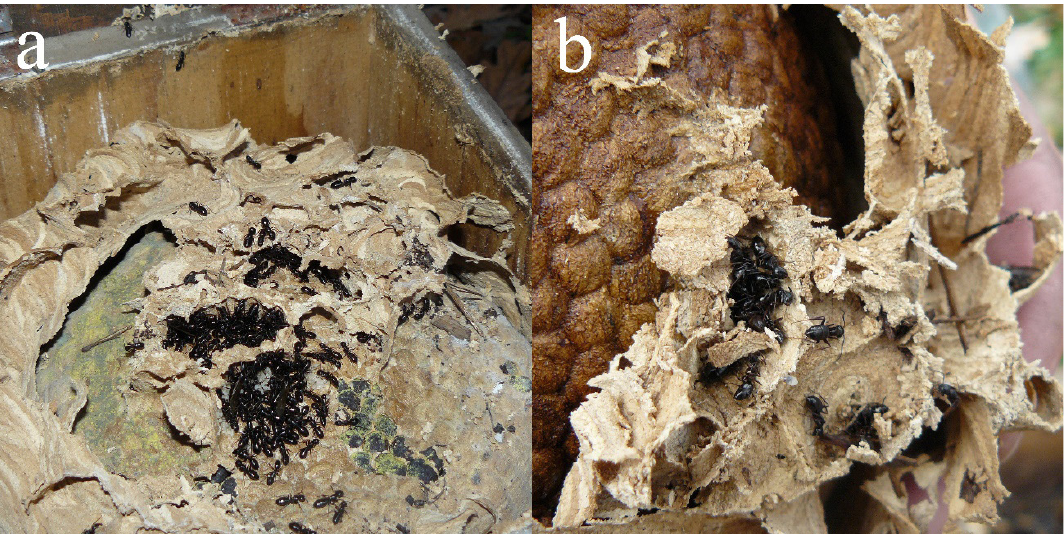
Fig 1 . a: adults (workers and reproductive specimens) and larvae of Camponotus fallax in the first nest. b: workers on the second